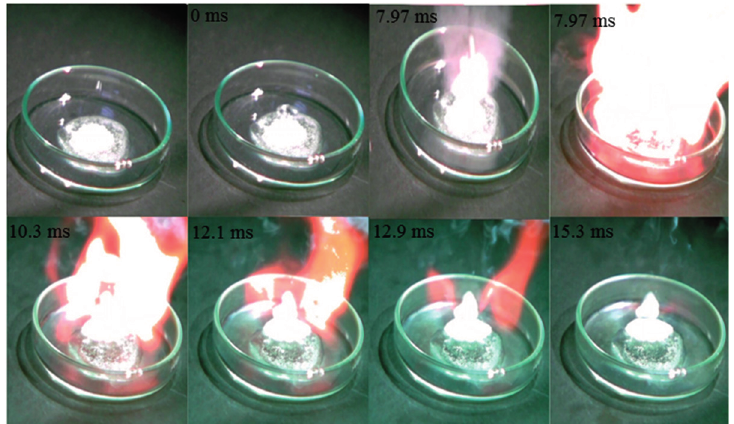
Figure 10. ID time photographs of the mixture hypergolic chemicals with [EMT] + [I] − and HOCH 2 CH 2 NHNH 2 using H 2 O 2 . Figure 11 shows the FT-IR spectrum of the explosion gas of a mixture with [EMT] + [CN] − and HOCH 2 CH 2 NHNH 2 using H 2 O 2 . The characteristic peaks were assigned as shown in Figure 10. However, nitro group peak indicating toxic chemicals were not observed in this experiment.